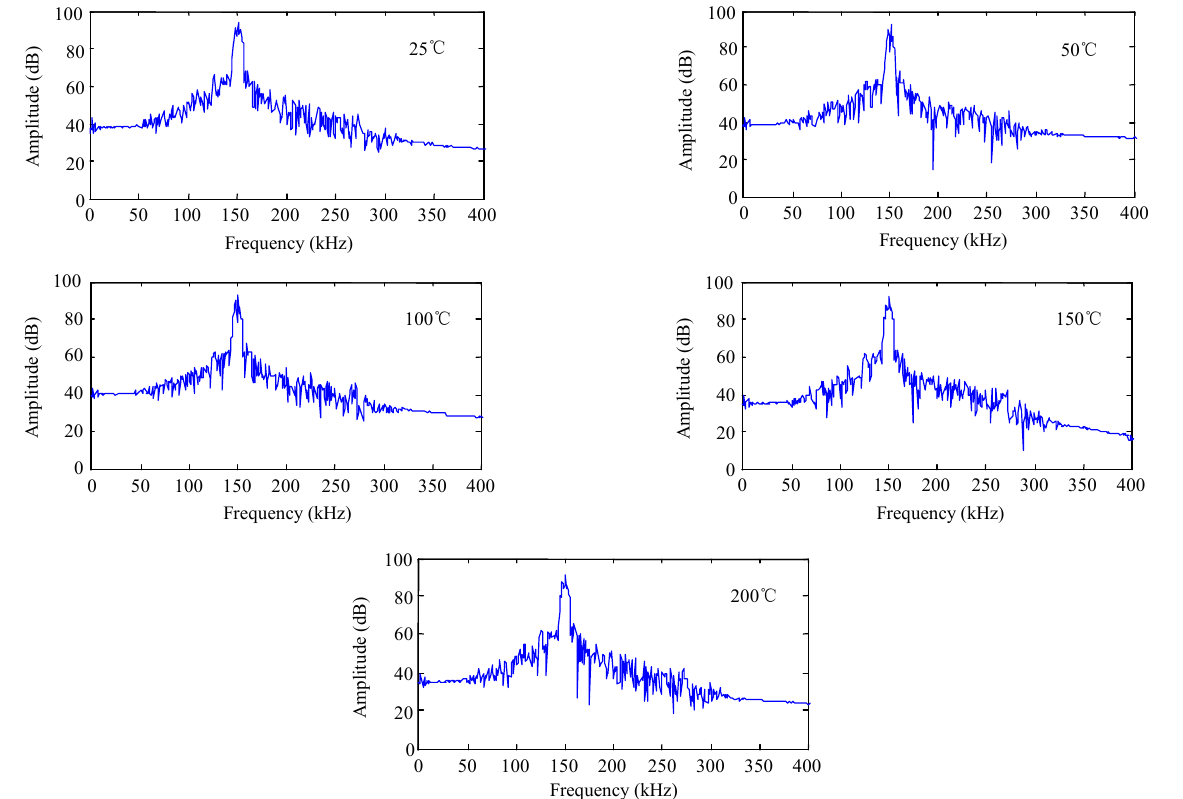
Fig. 8 Frequency response of the high temperature AE